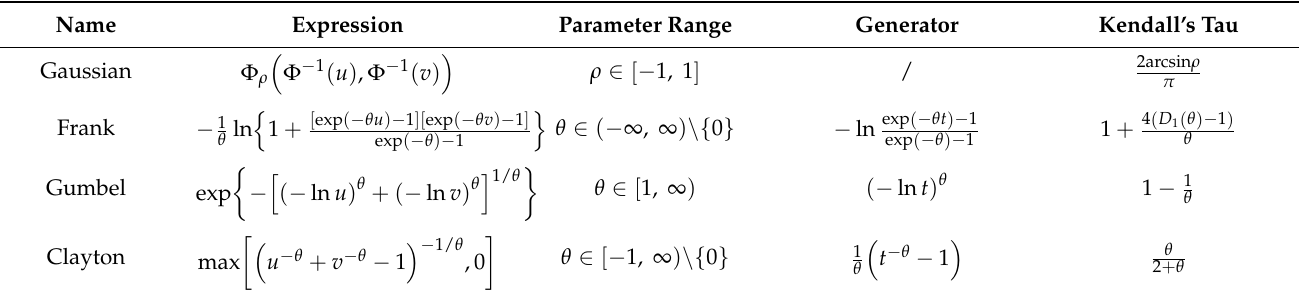
Table 2. The description of candidate